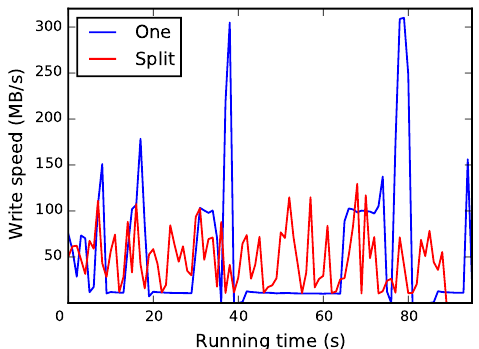
Fig. 10 Disk write speed over time with and without graph split.